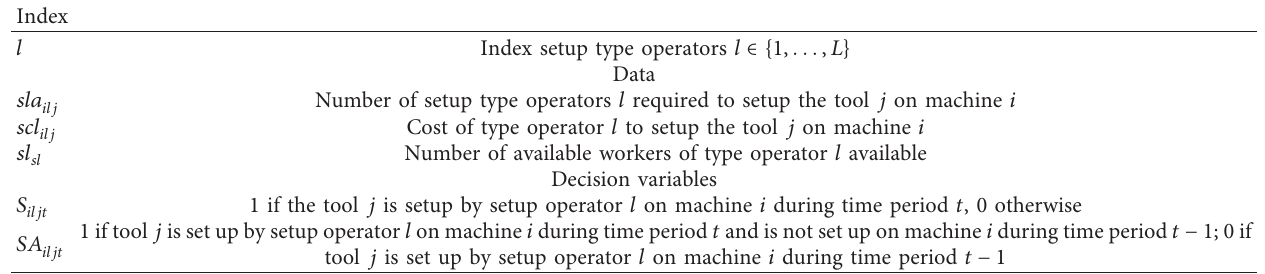
Table 3: Nomenclature for the